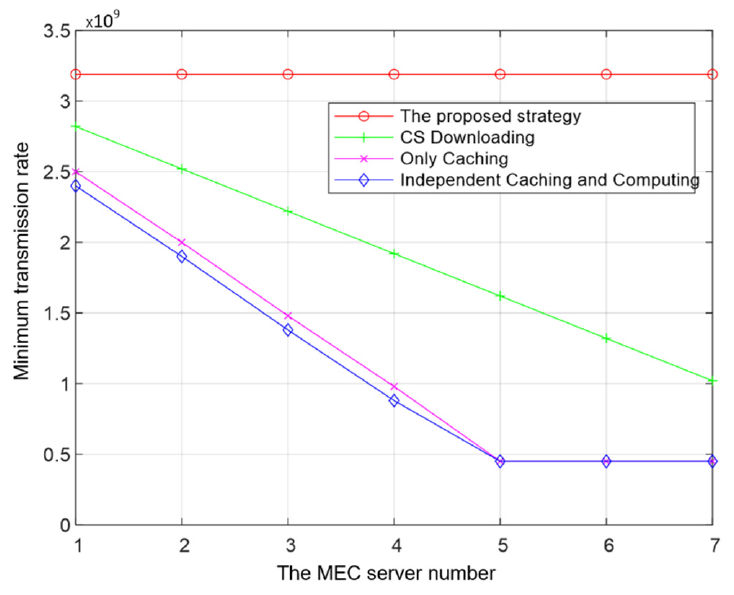
Figure 4. The effect of 𝐾 on 𝑅 and comparison with other schemes. The impact of f D on R at various P D levels is shown in Figure 5. With the suggested technique, the likelihood of 2CCL and 2CL-FM, or the local computing number, increases with P D , which causes R to decrease. The independent caching and processing method is only used as a benchmark, since the three contrast schemes have no effect on the computing power of the VR device. It goes without saying that the VR device has a significant impact on local